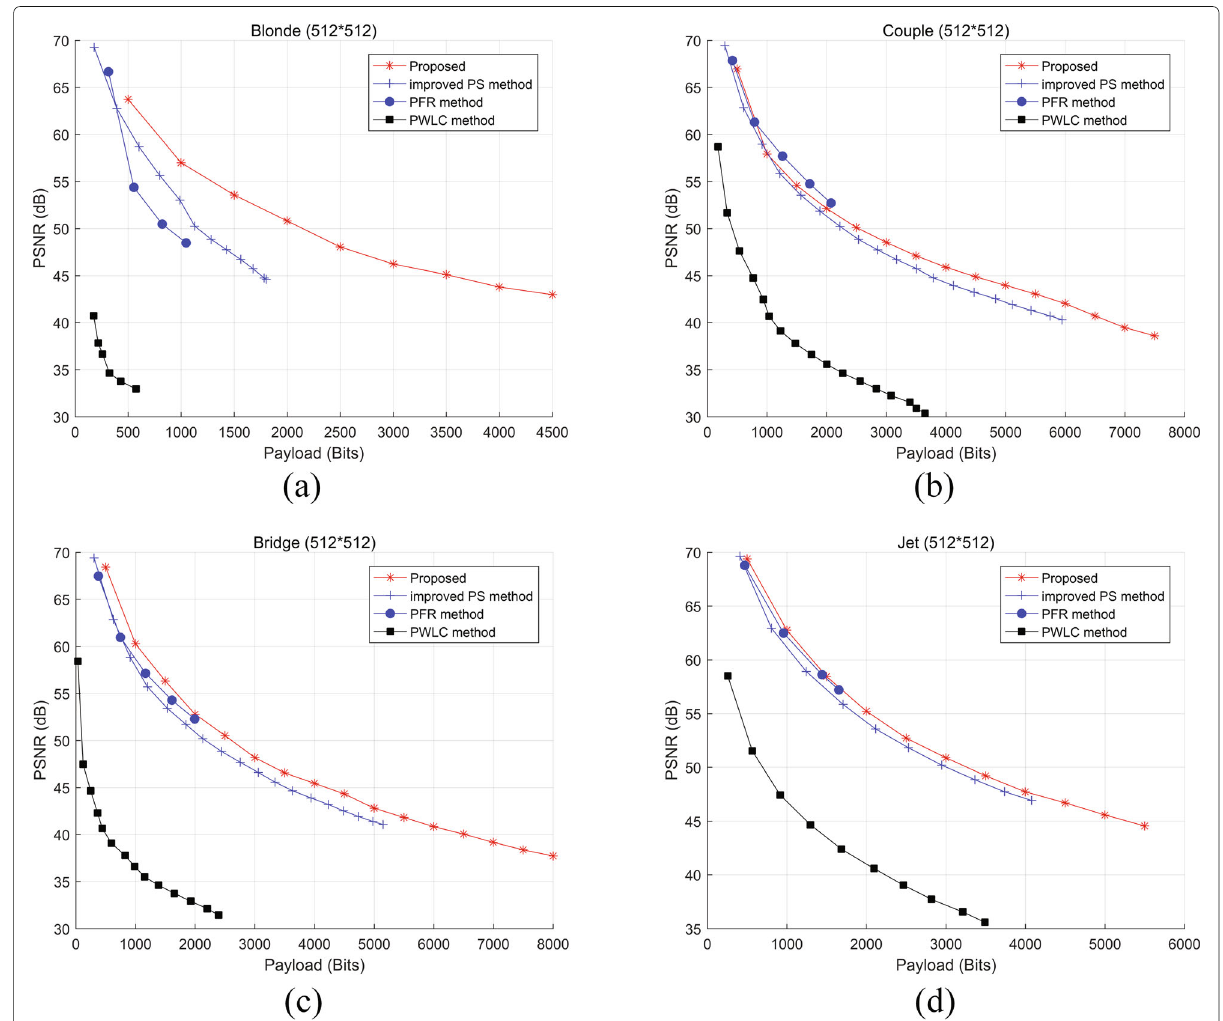
Fig. 12 Comparisons of PSNR and capacity (in